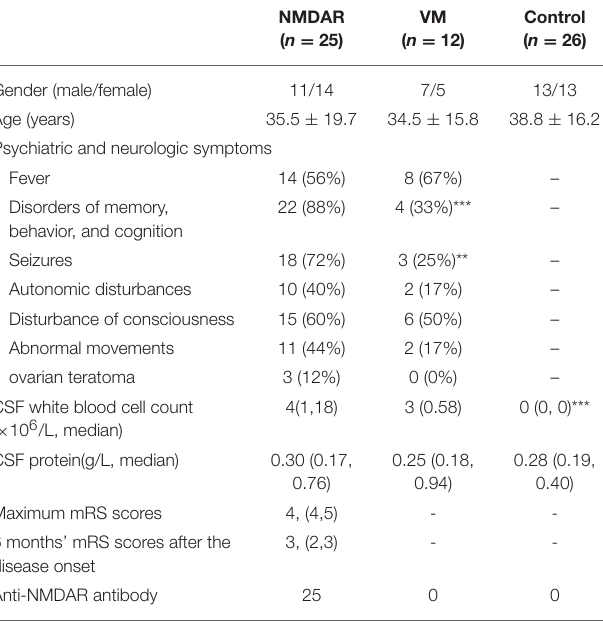
TABLE 1 | The clinic manifestations and baseline characteristics of anti-NMDAR encephalitis VM and